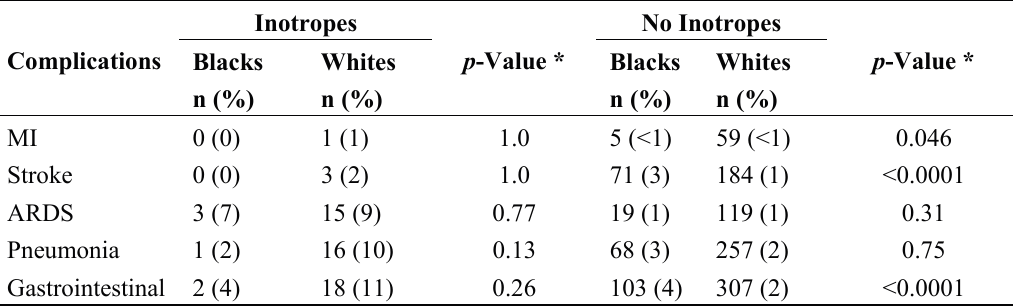
Table 3. Postoperative complications.